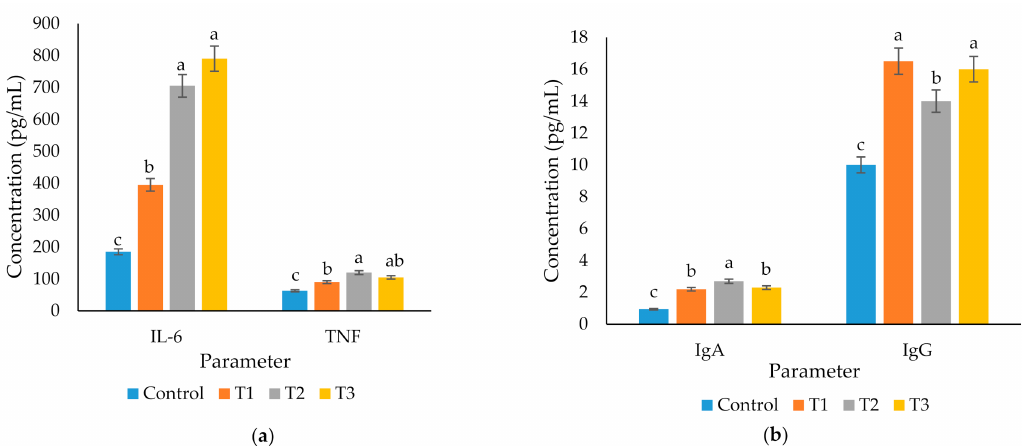
Figure 1. Effects of Mentha arvensis (MA) and Geranium thunbergii (GT) on immunity parameters. ( a ) Concentration of serum (IL-6) and tumor necrosis factor (TNF α ); ( b ) Concentration of serum immunoglobulins IgA and IgG. a,b,c Bars within a particular point not sharing a common letter differ significantly ( p < 0.05). n = Each value represents the mean of 6 replications with 3 birds per